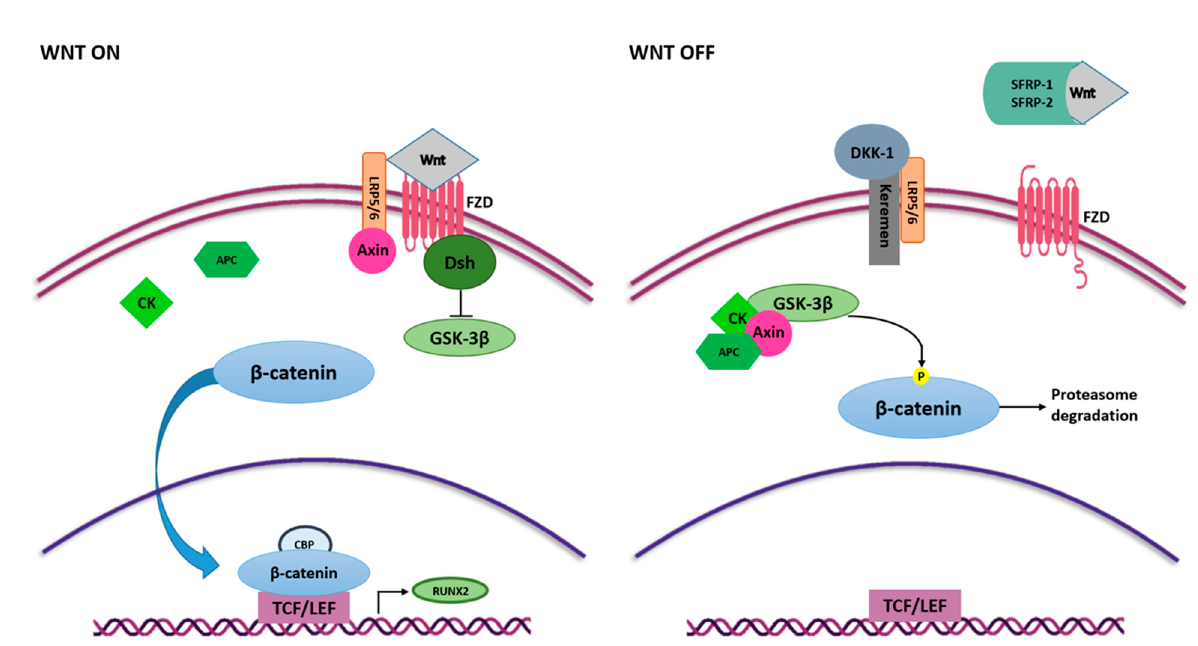
Figure 3. Wnt/ β -catenin signaling pathway in osteogenesis. Wnt ligands interact with FZD and activate Wnt signaling pathway. FZD binds Dsh that inhibits GSK3- β activity, and thus the phosphorylation of β -catenin. β -catenin translocates into the nucleus, where it binds to TCF/LEF and CBP and induces the expression of RUNX2 . Interaction between Wnt ligands and SFRP-1/2 and the binding of LRP5/6 and Keremen with DKK-1 antagonist switch off Wnt signaling pathway. In this case, GSK3- β , together with Axin, CK and APC, phosphorylate β -catenin, inducing proteasome-mediated degra- dation.